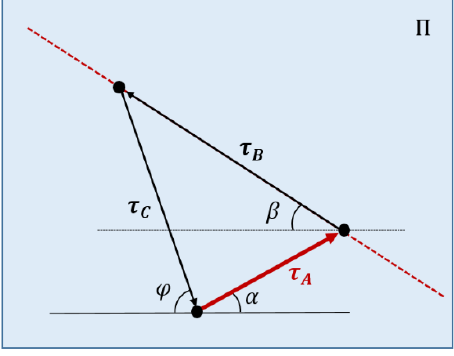
. Figure 8. Equilibrium of forces at point C i 𝐶𝐶 𝑖𝑖